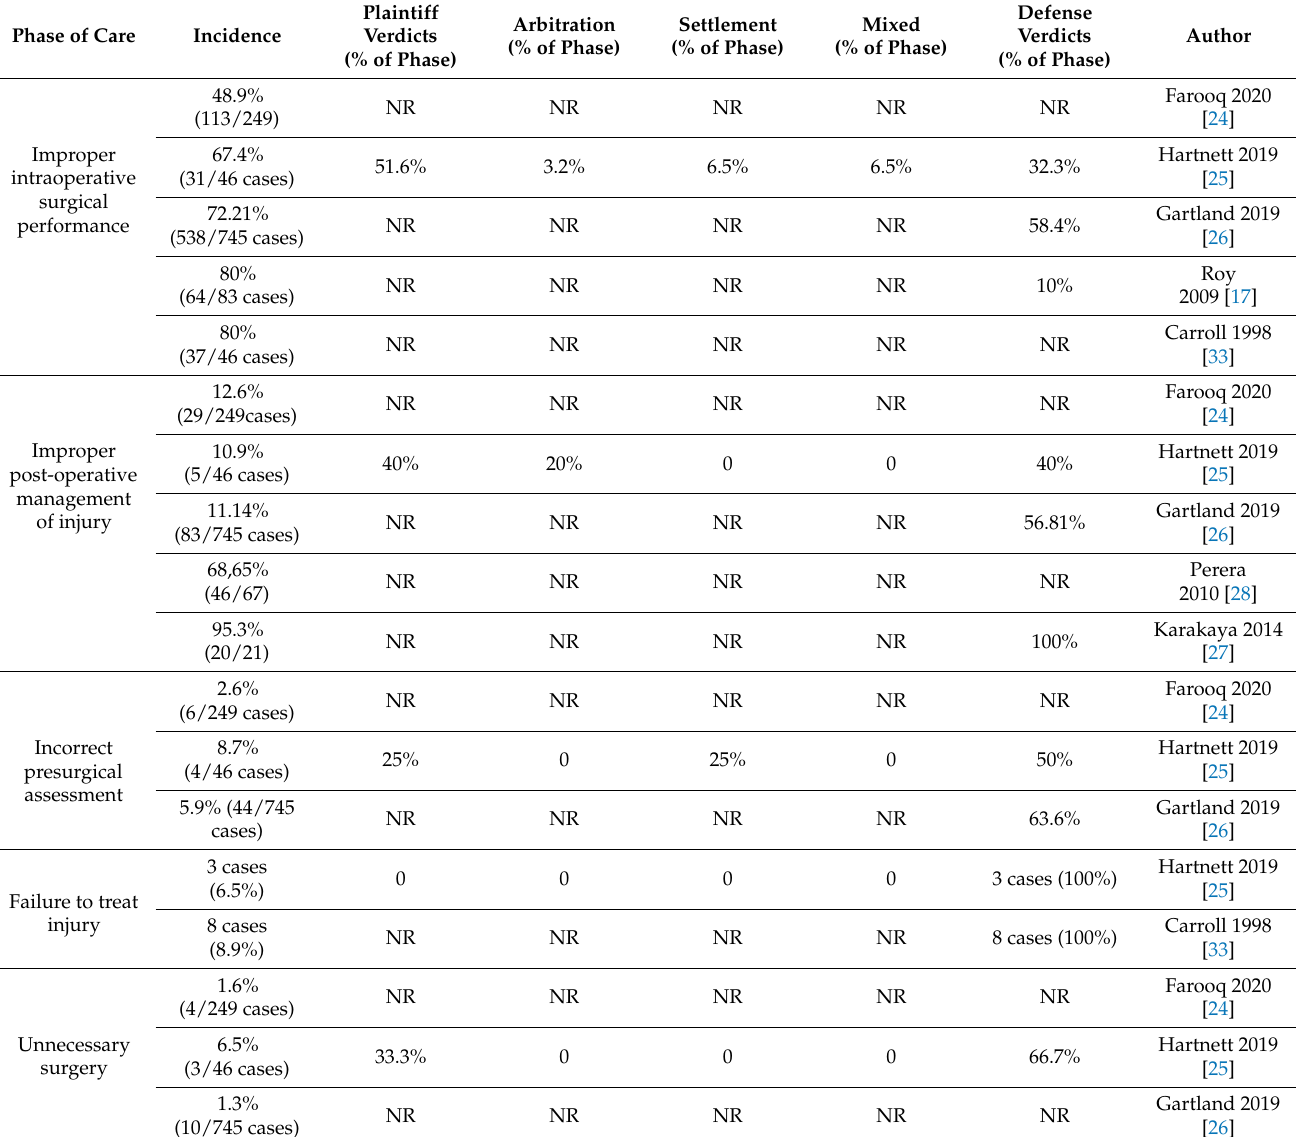
Table 2. Phases of care in which the request of claim for malpractice